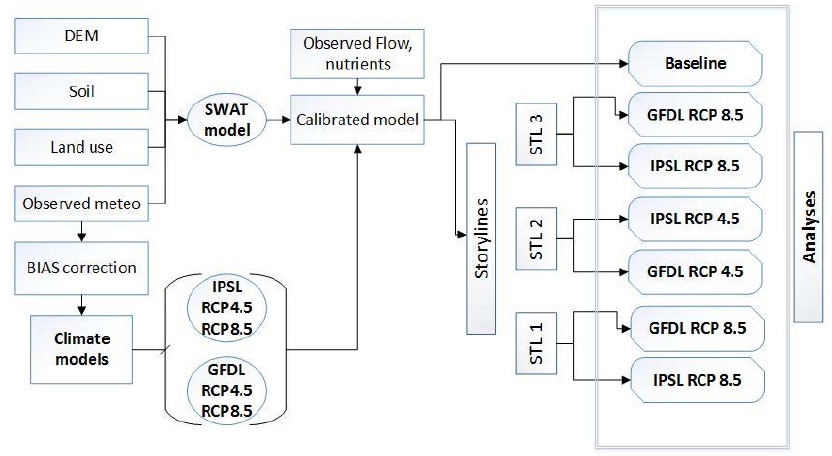
Figure 2. The schematic description of the modelling approach and considered scenarios (IPSL, IPSL-CM5A-LR model; GFDL, GFDL-ESM2M model; RCPs, Representative Concentration Pathways, STL, storylines).